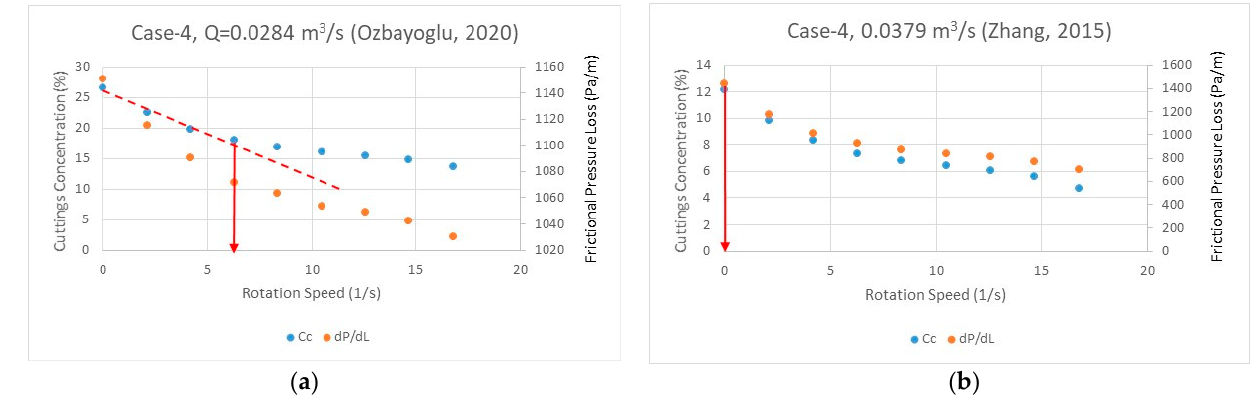
Figure 9. Determination of the optimal pipe rotation speed after the optimal flow rate is determined for Case 3: ( a ) Ozbayoglu’s model and ( b ) Zhang’s model.